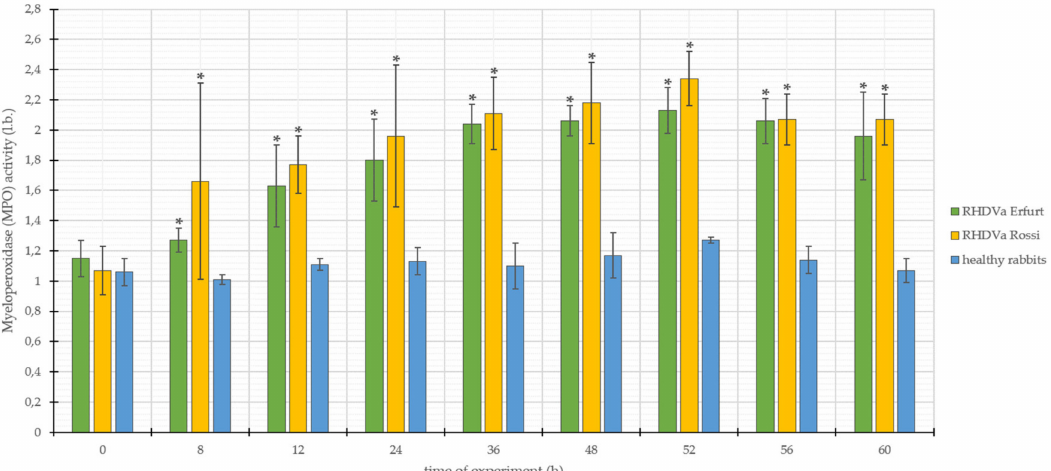
Figure 2. Values of myeloperoxidase (MPO) activity in rabbits infected with L. europaeus / GI.1a / Erfurt and L. europaeus / GI.1a / Rossi, as well as control rabbits. * statistically significant change with respect to the control group ( p < 0.05).